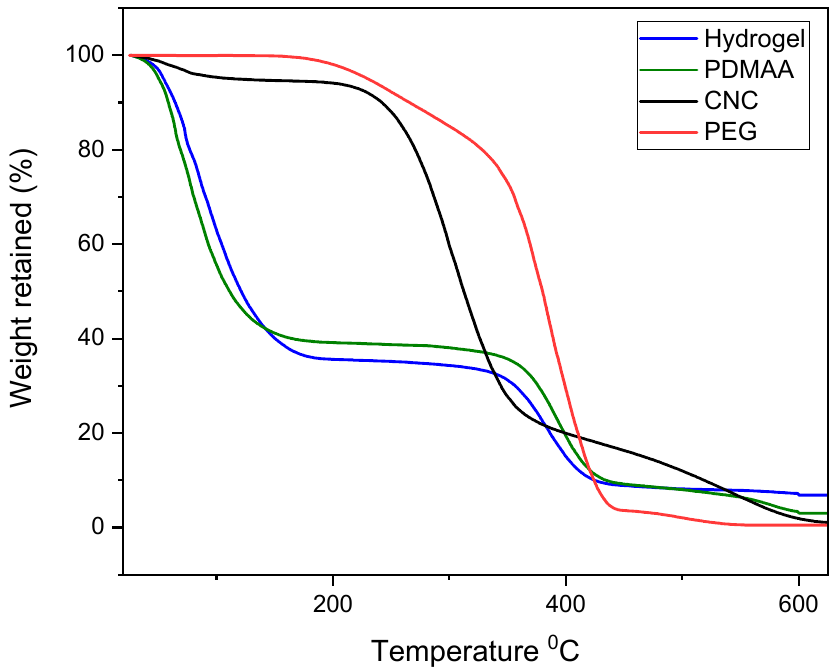
Figure 4. TGA curves of CNC, PEG, PDMAA and CNC/PEG/PDMAA semi-IPN hydrogel.